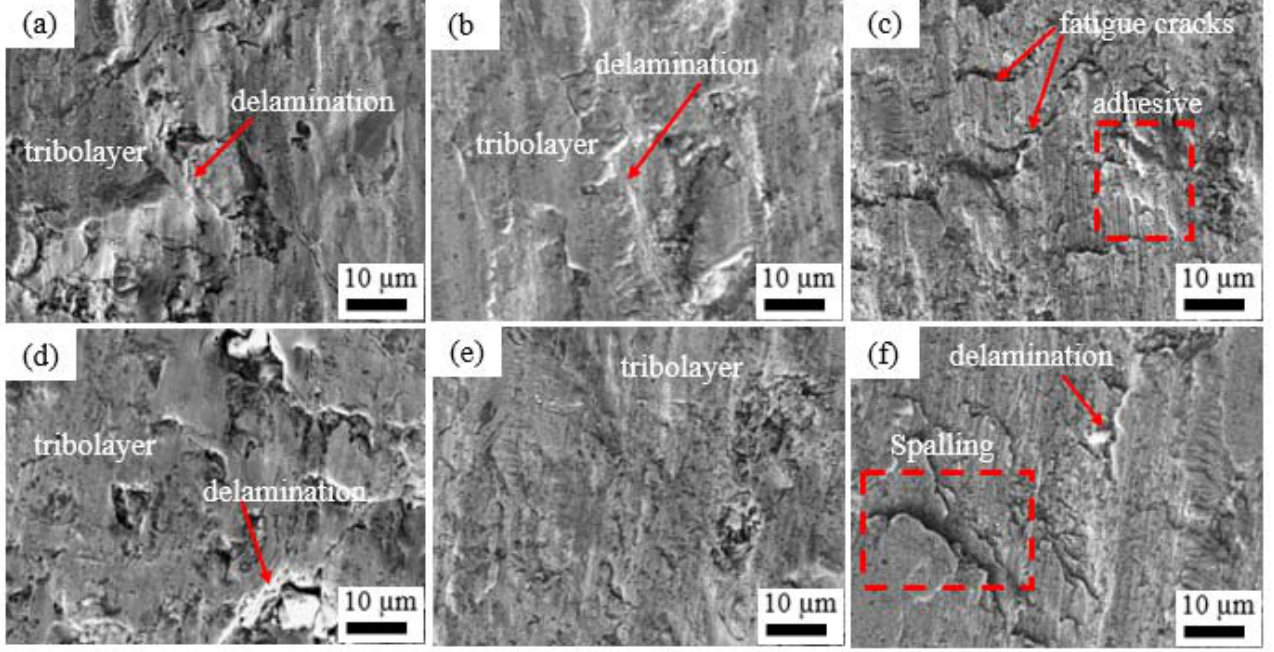
Figure 11. SEM images of the worn surfaces for the heat ‐ treated coatings: ( a ) P 500/600°C ; ( b ) P 500/800°C ; ( c ) P 500/1000°C ; ( d ) P 700/600°C ; ( e ) P 700/800°C and ( f ) P 700/1000°C